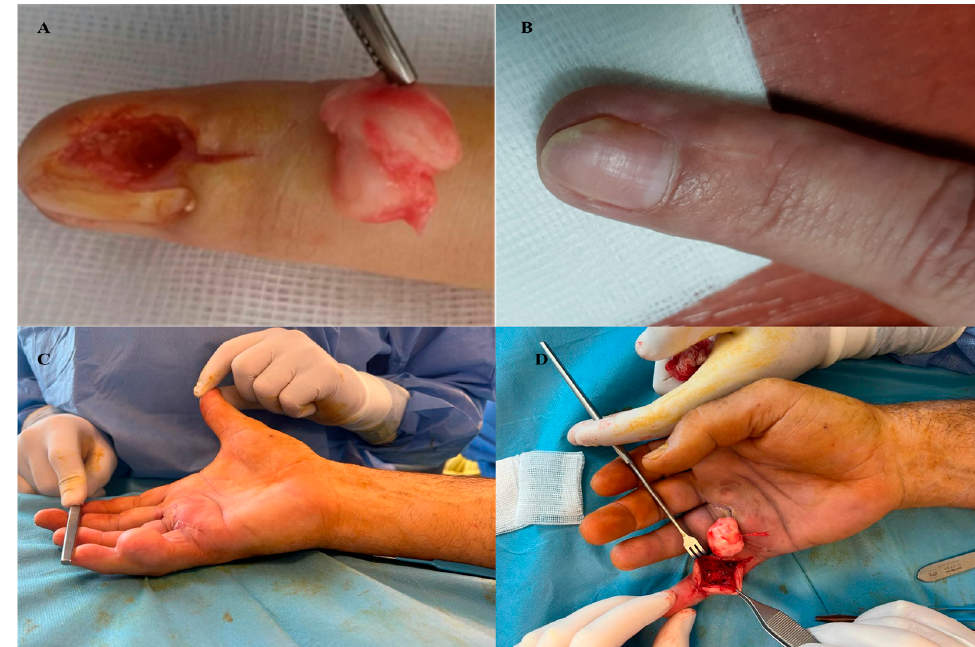
Figure 2. ( A ) intraoperative aspect, ( B ) Neurofibroma of the nail bed—1 year postoperatively result, ( C ) Large neurofibroma on the volar face of the fifth finger, right hand—preoperative aspect, ( D ) Large neurofibroma on the volar face of the fifth finger, right hand—tumor ablation and the recipient site.